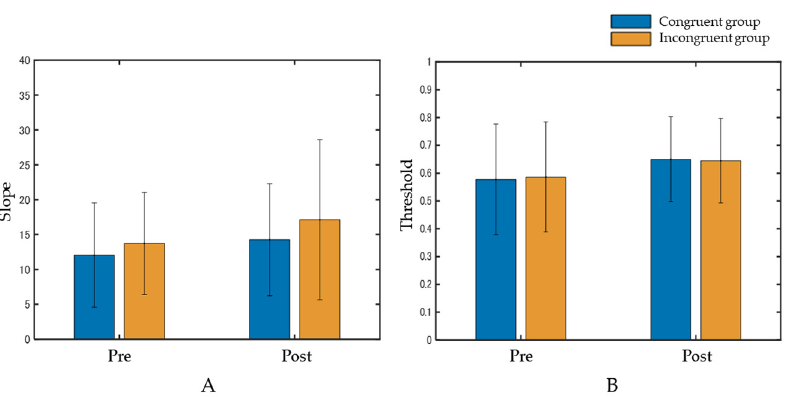
Figure 4. Results of the slope ( A ) and the threshold ( B ). Data represent means ± standard deviation. Both the interaction and main effects were not significant.